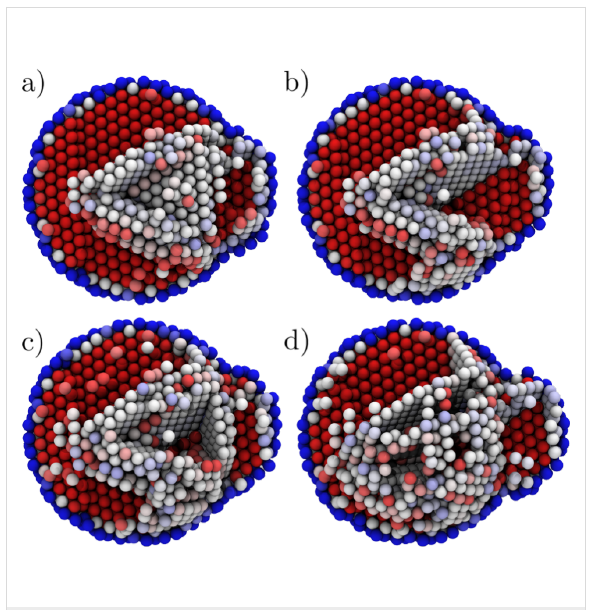
Figure 7: Atomic arrangement during the breaking of the dendrite. (a–b) The locking multijunction (see Figure 6) is broken as the <112> partial is disassociated from the junction. (c–d) A partial nucleated at the particle surface (here lower right about the orifice) interacts with the partials in the dendrite pinned to the surface, resulting in a slip.